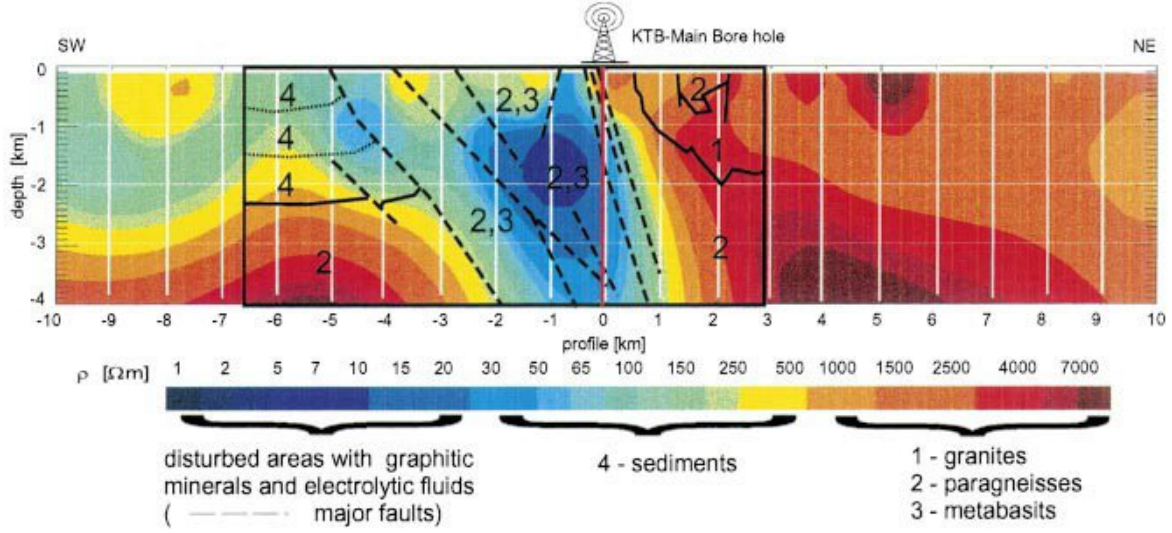
Figure 5. Deep ERT image obtained close to KTB facility (Germany); the conductive anomaly in the central part of the profile is associated to the presence of a fault zone with fluids. (Reprinted with permission from [28], Copyright (2000), Wiley-Blackwell Publishing Ltd.).